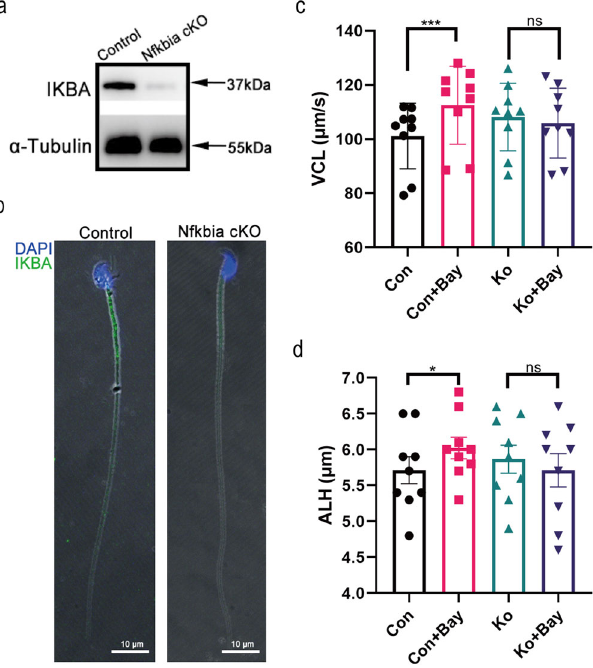
Fig. 7 IKBA-/- mouse sperm showed no response to Bay117082. a Expression level of IKBA in control and Nfkbia cKO mice sperm. α -Tubulin was applied to assess protein loading. b Distribution of IKBA in sperm of control mice and Nfkbia cKO mice. DAPI (blue) labeled the nuclei, and IKBA was stained with Alexa Fluor 488 (green). Images were merged (MERGE) with bright- fi eld images (Bright). Scale bar: 10 μ m. c , d Changes in VCL and ALH of control and Nfkbia cKO mice sperm treated with or without Bay117082 for 10 min. Values represent mean ± SEM ( n = 9), * p < 0.05, *** p < 0.001, compared with the corresponding control (0 μ M). ns, no signi fi